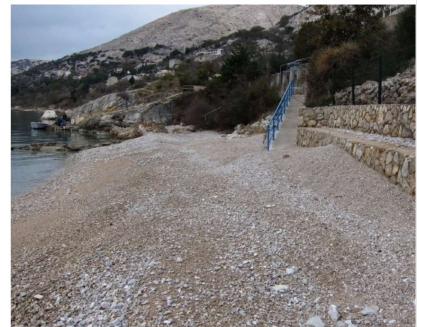
Figure 14. Winter beach profile formation after extreme tide 1.27 m CVD on 29 October 2018. Landslides are in the creeping phase and damage (open joint cracks) is visible on adjacent houses [60]. The improvised coastal wall, constructed in 2019, cannot stop the movements of the landslide body (Figure